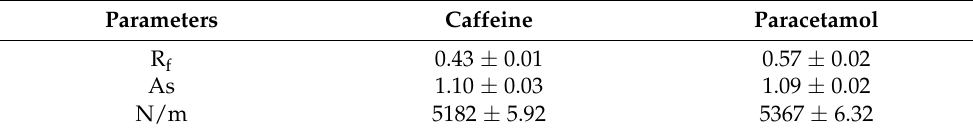
Table 4. The R f , As, and N/m values of caffeine and paracetamol for the greener reversed-phase HPTLC method (mean ± SD; n = 3).